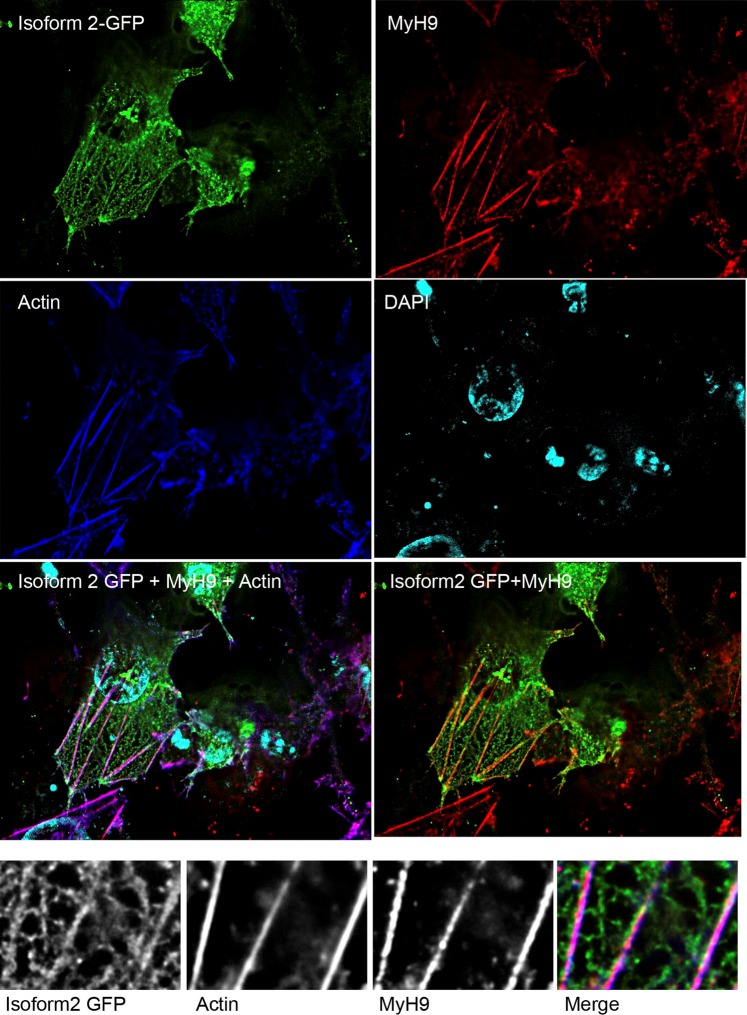
Co-localization of Dlc1 with Myh9. Immunostaining of GFP-Dlc1 isoform 2-transfected OC-033 cell line. The cells were stained with an anti-Myh9 antibody, followed by fluorescently labelled secondary antibody and counterstained with Phalloidin (Actin) and DAPI. The actin and Myosin 9 were found to be co-localized with GFP-Dlc1 isoform 2 along the length of the stress fibres. The merged image at the bottom row has the same colour scheme as in the top panels.